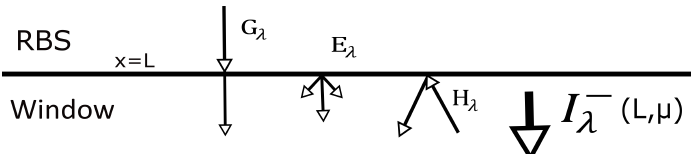
Figure 3. Schematic representation of radiation intensity at the boundary x = L